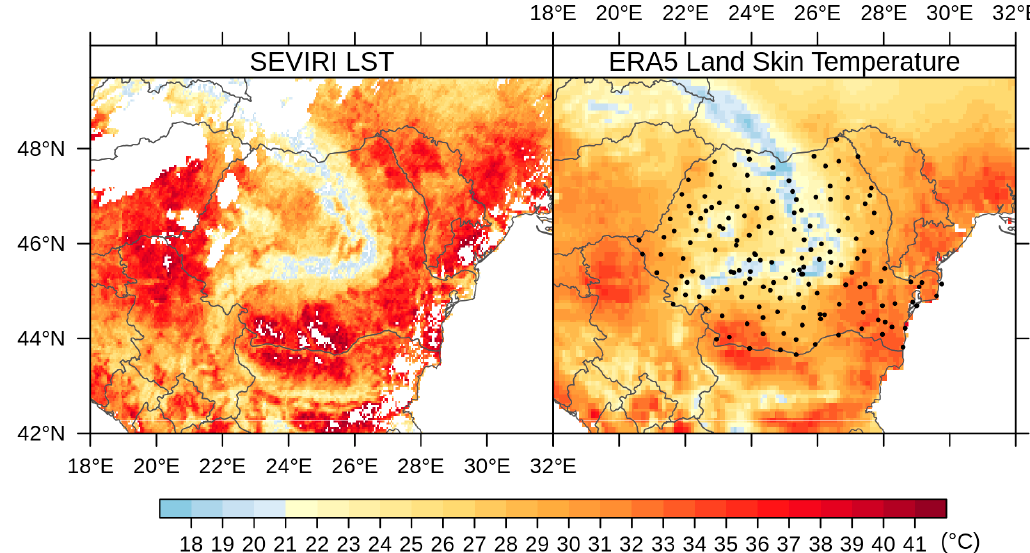
Figure 1. SEVIRI LST ( left ) and ERA5 Land Skin temperature ( right ): 2017-08-25 09 UTC. The black dots from the right panel are the weather stations of the Romanian National Meteorological Administration.